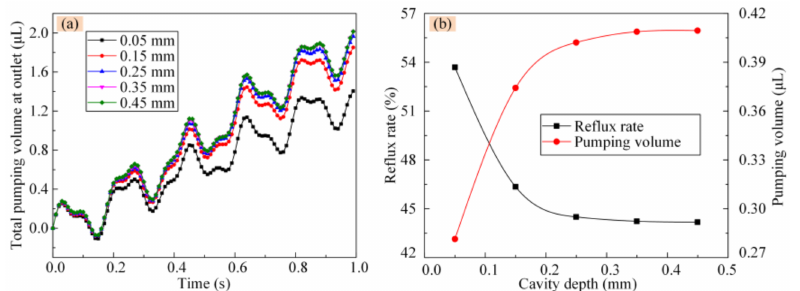
Figure 8. The pumping performance of the designed valveless piezoelectric micropump with different cavity depths. ( a ) The total pumping volumes varies with different cavity depths; ( b ) The reflux and pumping volume verse cavity